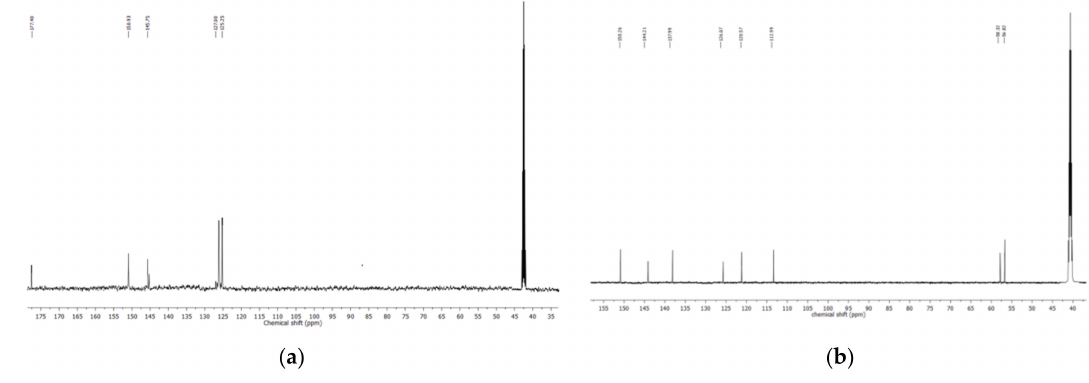
Figure 5. 13 C NMR spectra of C1 ( a ) and C2 ( b ) measured in DMSO-d 6 .